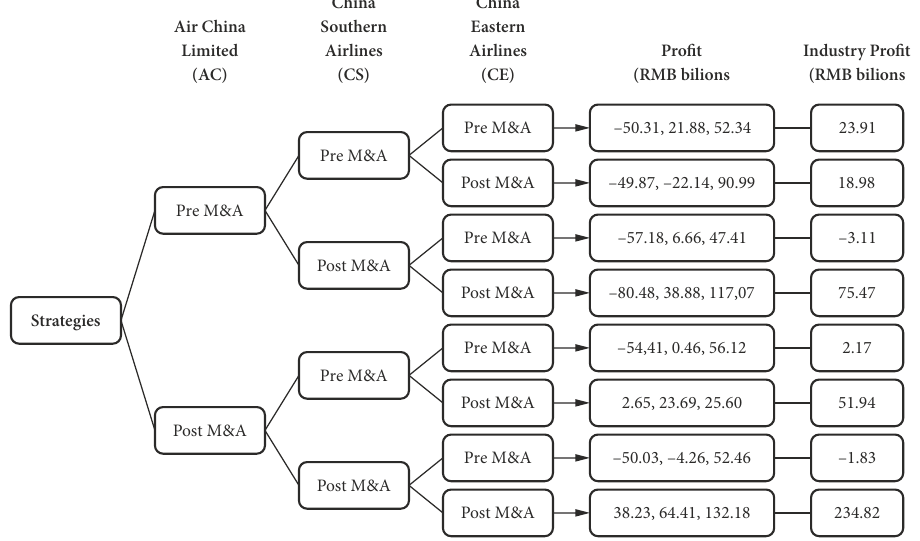
Figure 4. Optimal profit for AC, CS, CE and the aviation industry under Cournot